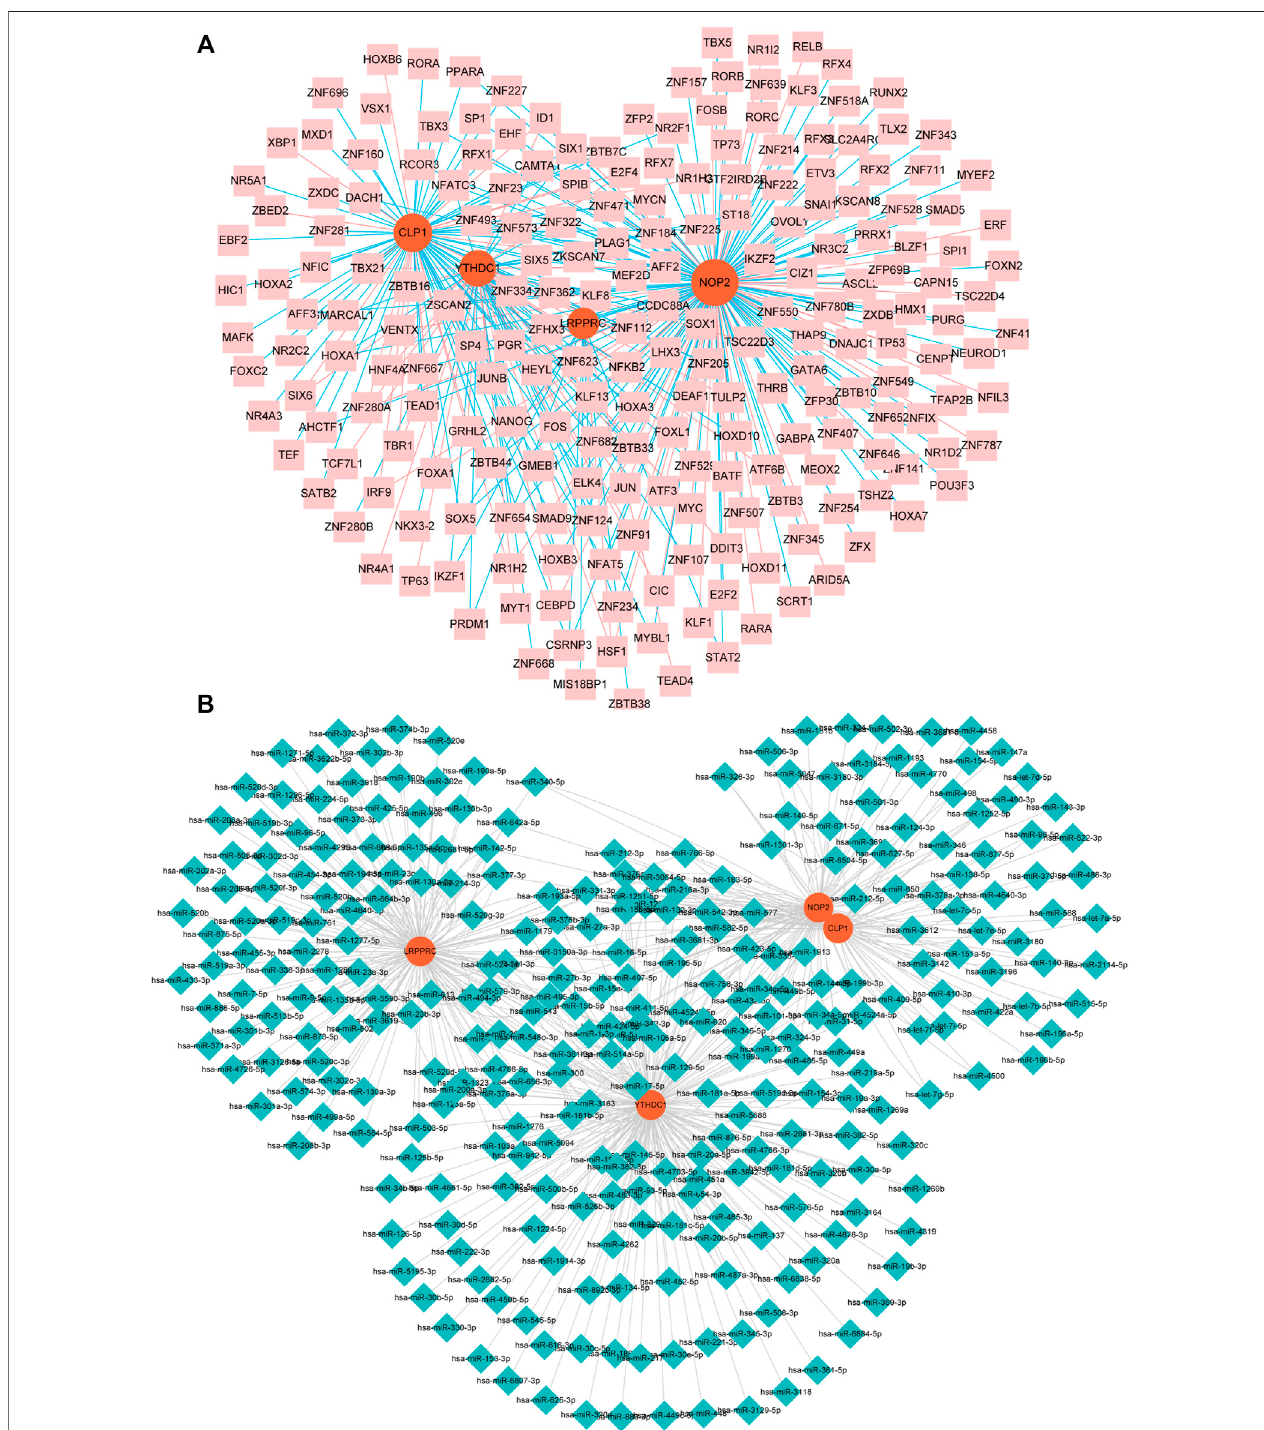
FIGURE8| miRNA-andTF-RNAmodi fi ernetworkconstruction. (A) :mRNA-TFnetworkofhubgenesrelatedtoRA,pinknodesindicateTF,rednodesindicatekey genes related to RA. (B) : Keys related to RA in the mRNA-miRNA network of genes, the blue nodes represent miRNAs, and the red nodes represent key genes related to